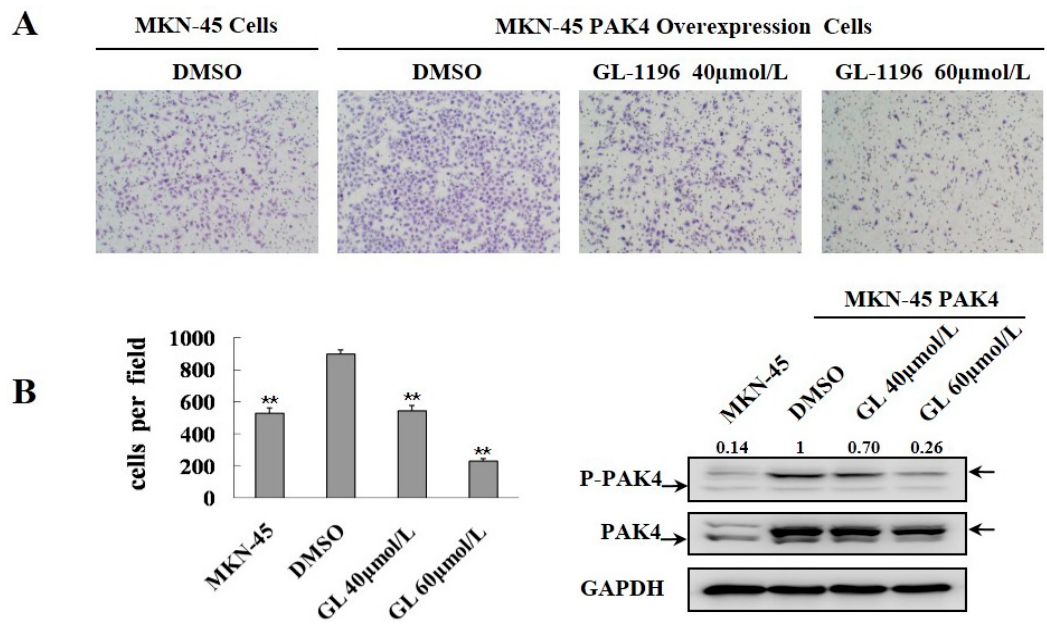
Figure 6. GL-1196 treatment exhibited the same inhibitory invasive effect on PAK4-overexpression MKN-45 cells as the control MKN-45 cells. ( A ) the invasive ability of PAK4-overexpression and control MKN-45 cells was evaluated by using a Boyden chamber matrigel invasion assay. The magnification is 100×, and the number of cells invading is shown as bar diagram ± SEM ( B left), ** p < 0.01. Western blot analysis shows the protein level of PAK4 in cells ( B right).